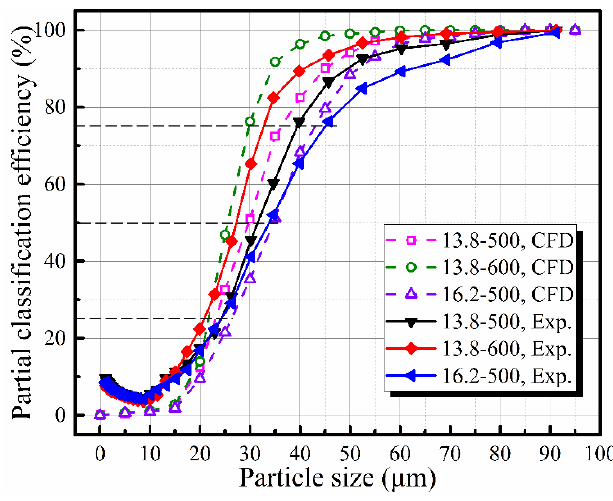
Figure 15. Partial classification efficiency curves for the experiment and simulation. Table 6. The cut size, classification accuracy, and pressure drop for the experiment and simulation.